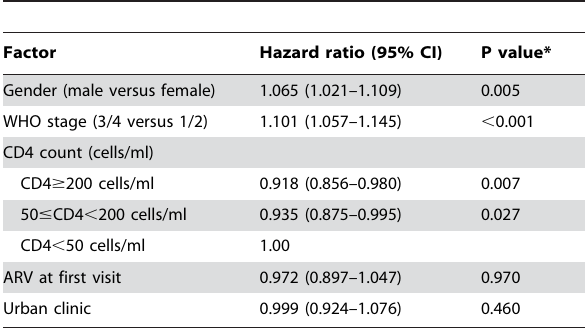
Table 2. Results of the Cox proportional hazards model of patient dropout.